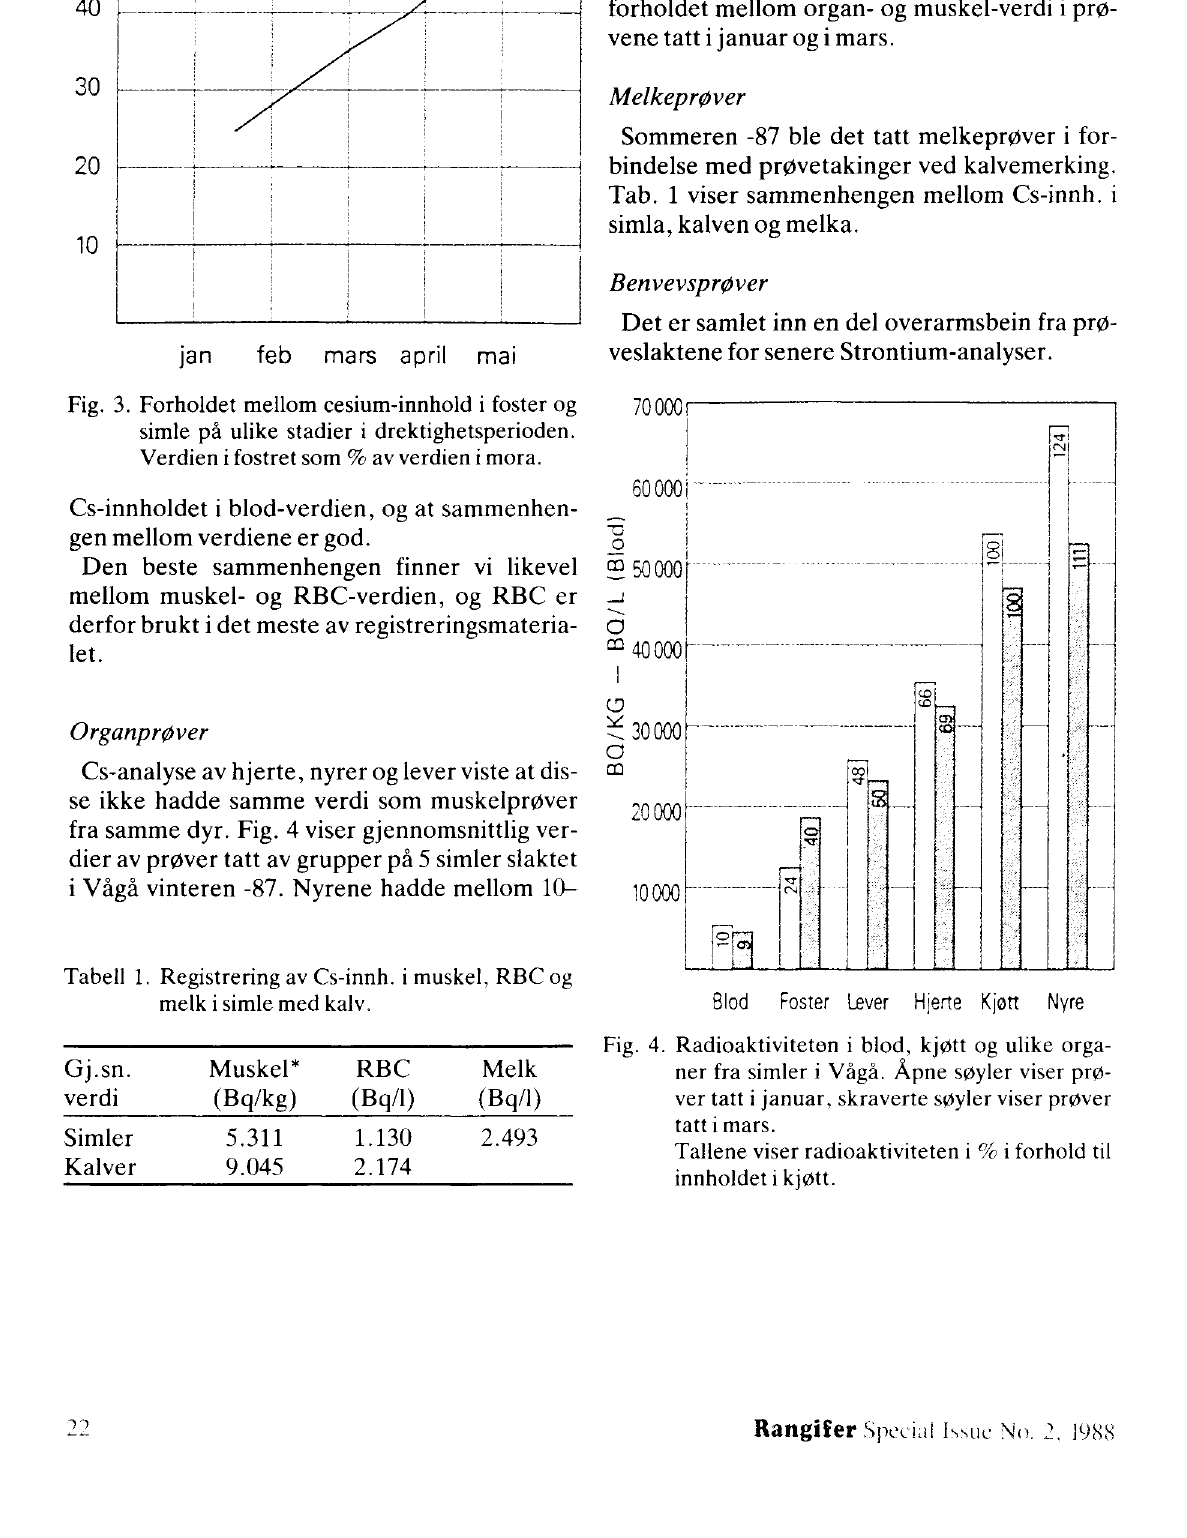
Fig. 3. Forholdet mellom cesium-innhold i foster og simle på ulike stadier i drektighetsperioden. Verdien i fostret som % av verdien i mora. Cs-innholdet i blod-verdien, og at sammenhen